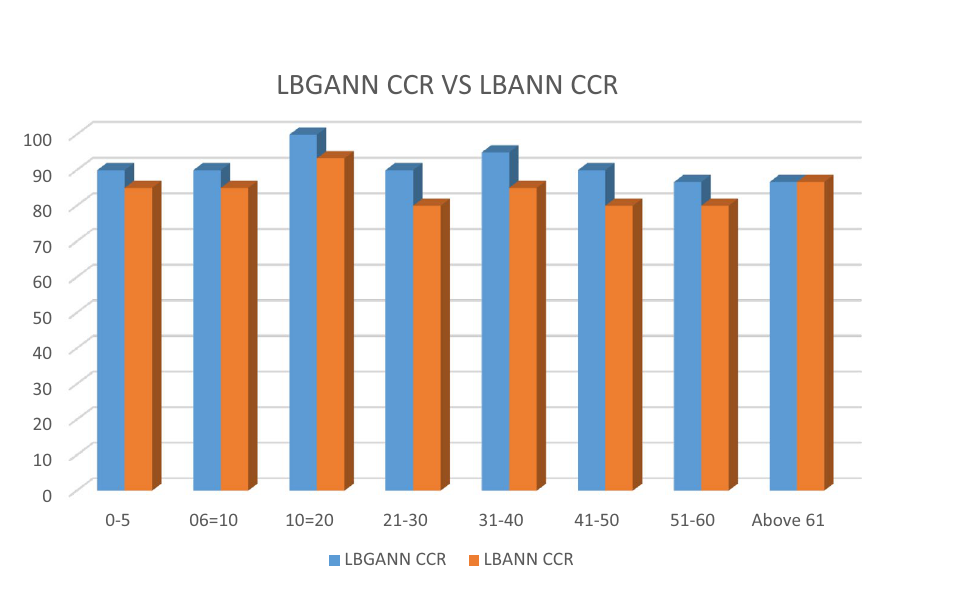
Figure 13. LBPGANN CCR and LBANN